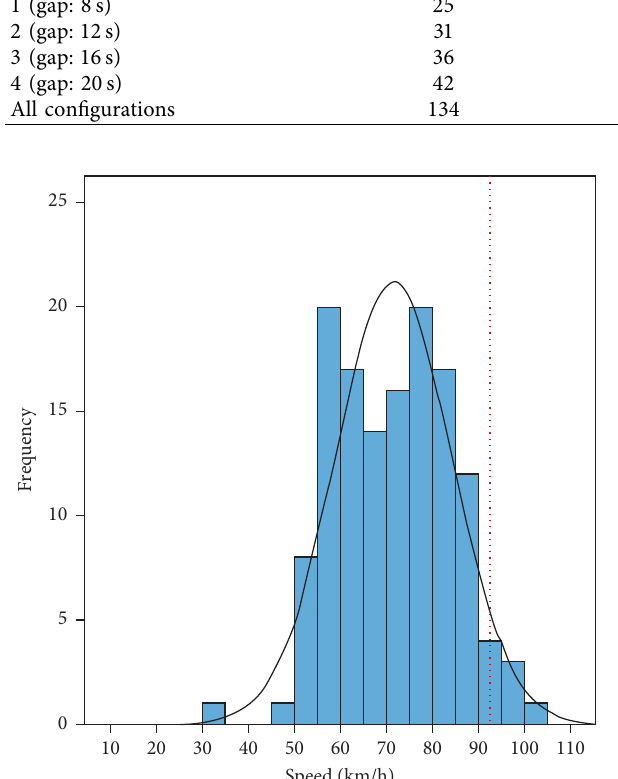
Figure 4: Histogram of speed data at the end of passing